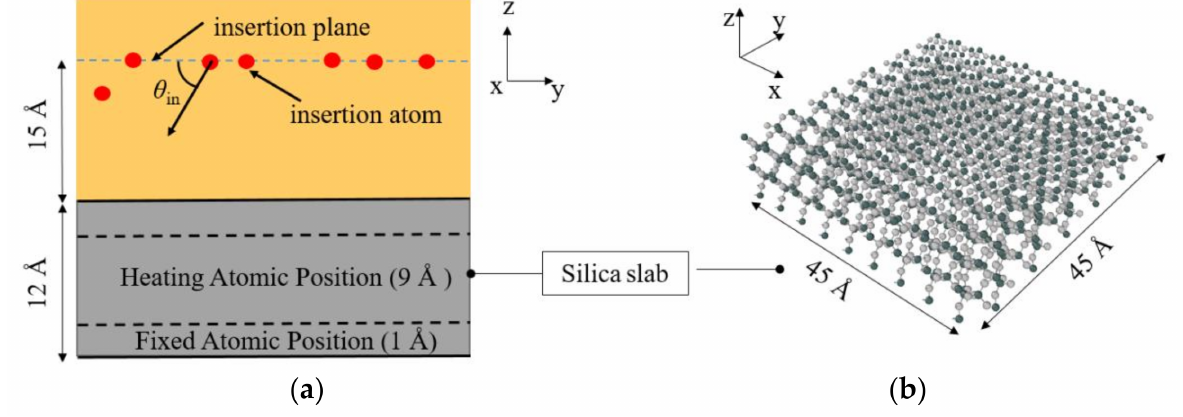
Figure 2. Schematic illustration of gas-solid interaction (GSI) model with flux boundary. ( a ) the RMD simulation configuration for the gas-solid interface ( b ) the silica surface